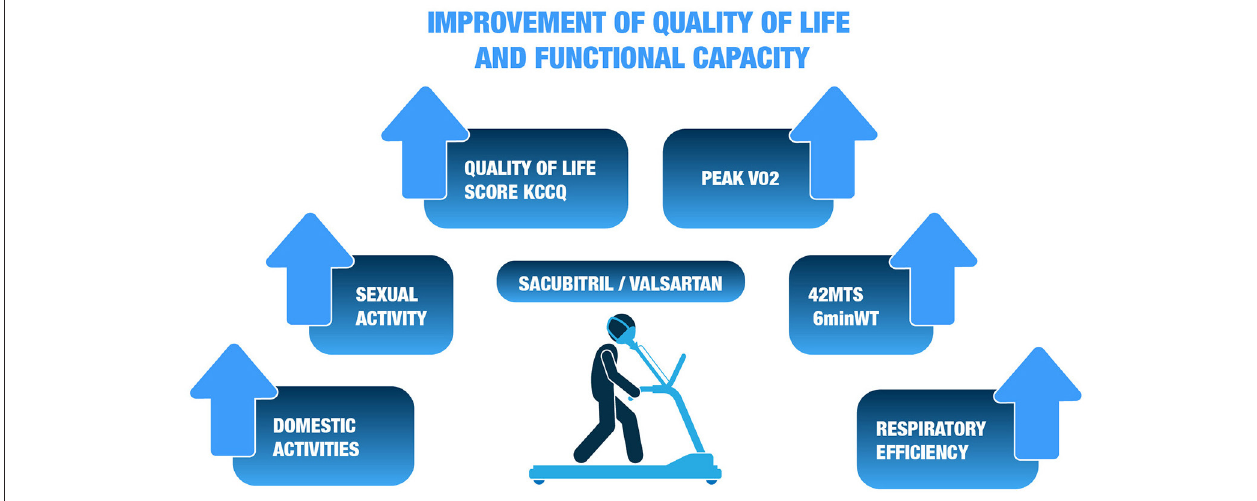
FIGURE 8 | Effect of sacubitril/valsartan relative to enalapril on different components of quality of life 99 . KCCQ, Kansas City cardiomyopathy questionnaire; MTS, meters; 6minWT, 6-minute walk test; VO2, Oxygen uptake.